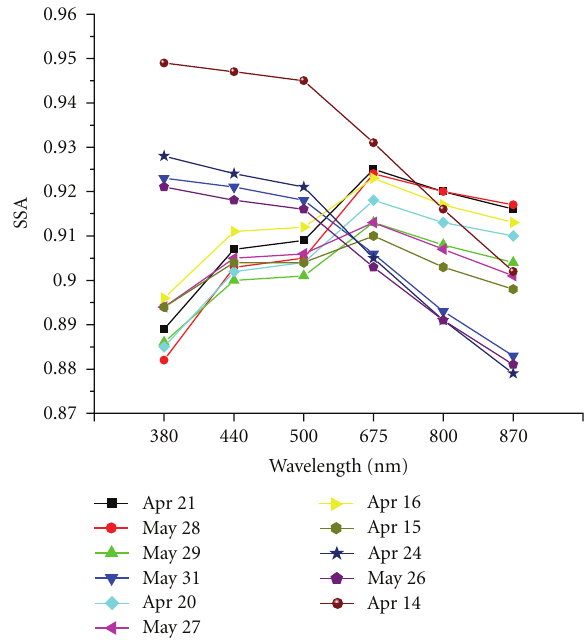
Figure 8: Spectral variation of OPAC-derived SSA values during dusty days over